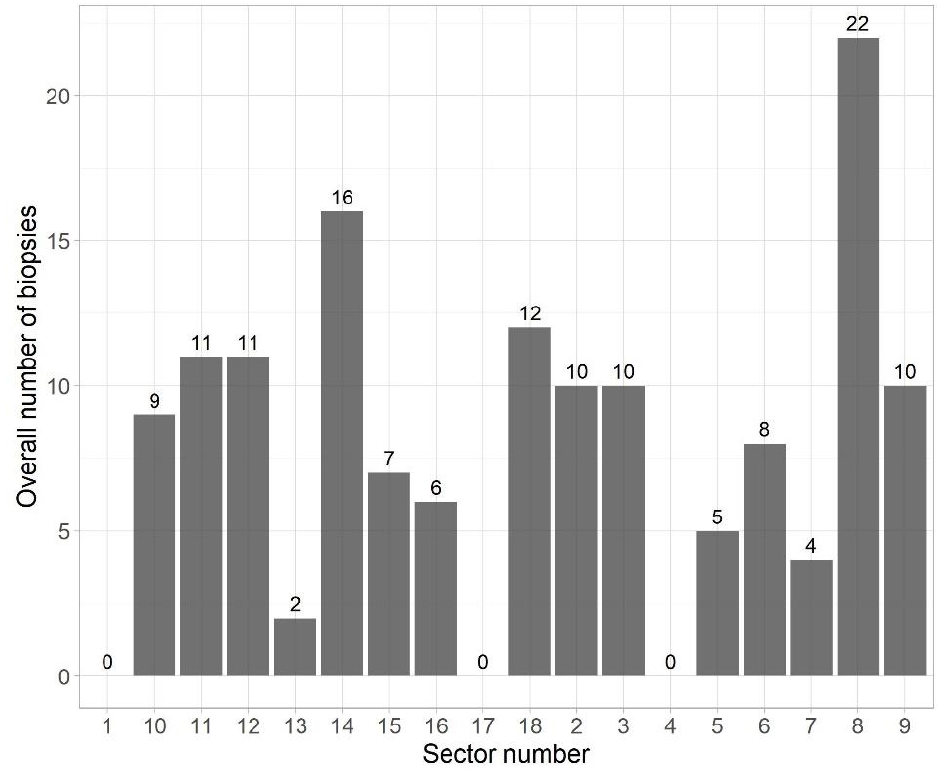
Figure 1. The overall number of biopsies taken from a given prostate sector.